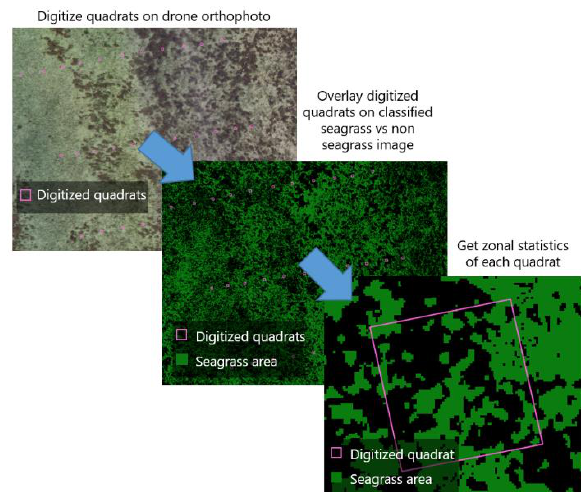
Figure 5. Process of calculating the percent cover of seagrass from UAV classified images